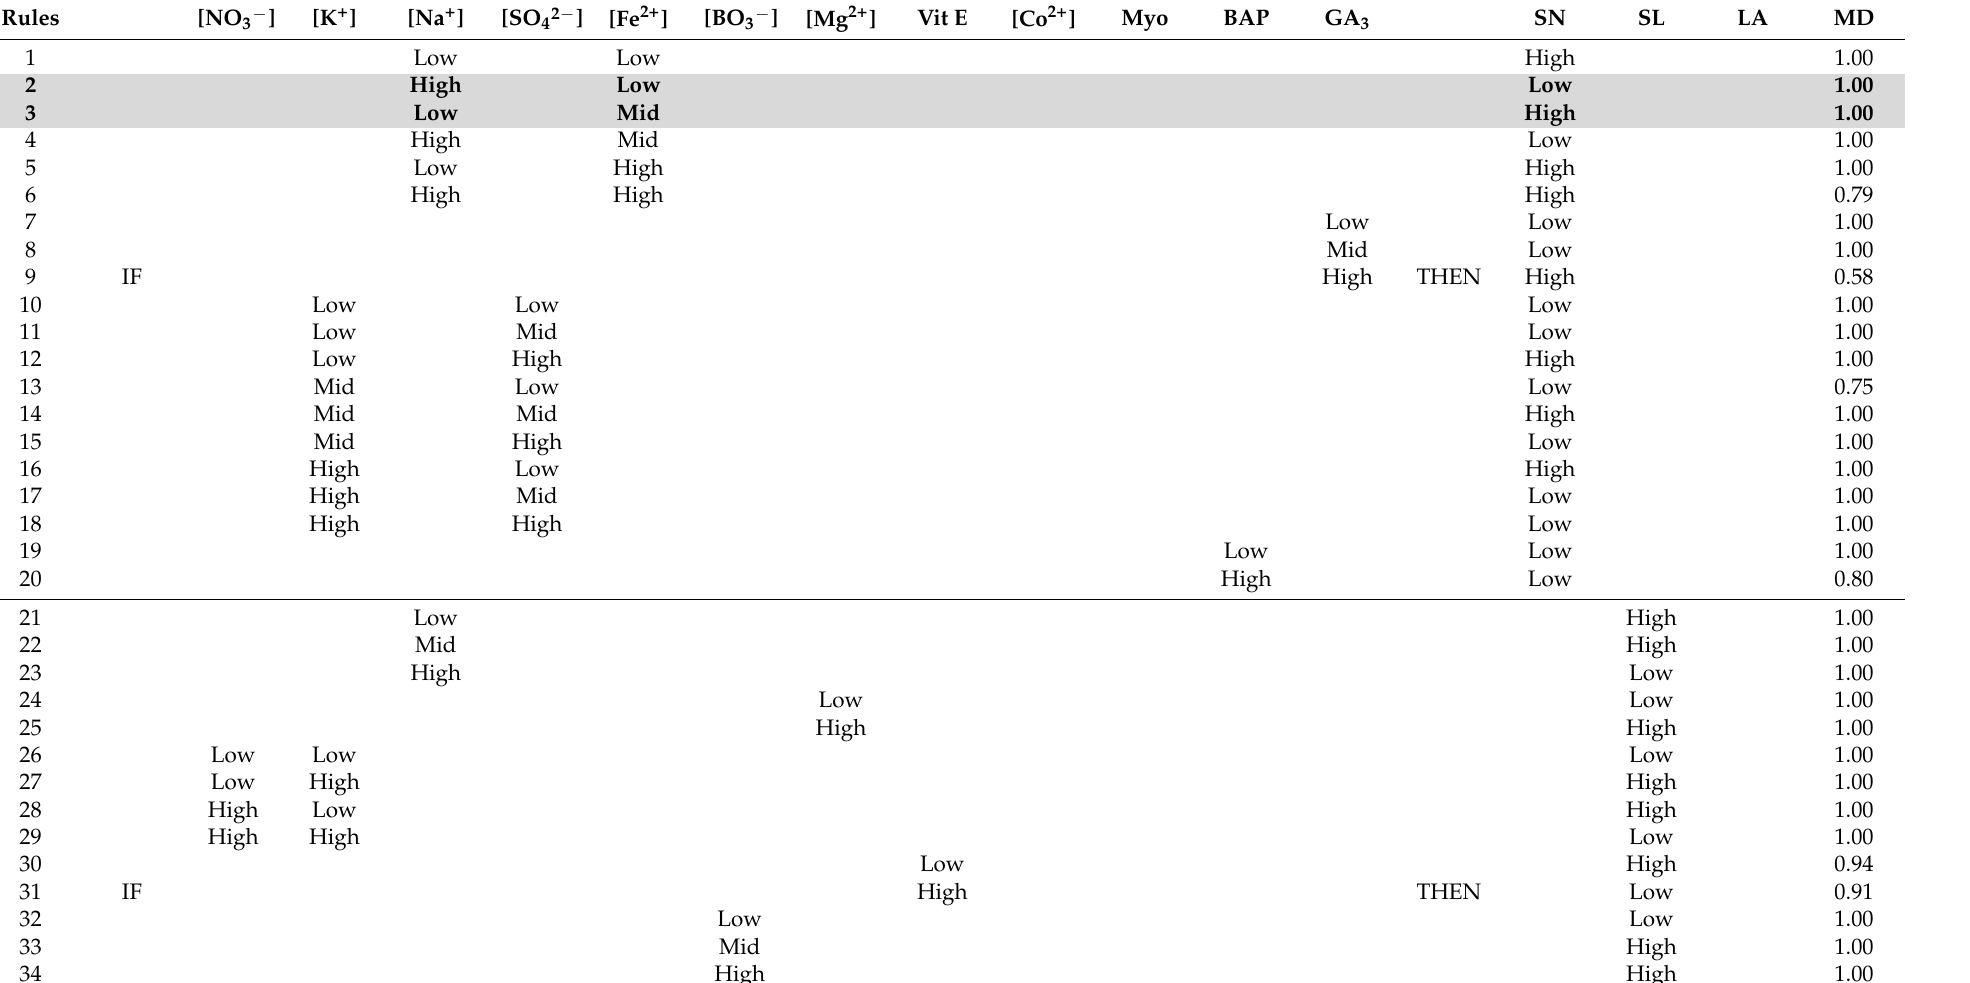
Table 2. Rules for morpho-physiological growth responses (SN: Shoot number; SL: Shoot length and LA: Leaf area) with their membership degree (MD) generated by neurofuzzy logic. The inputs with the strongest effect indicated by the model have been